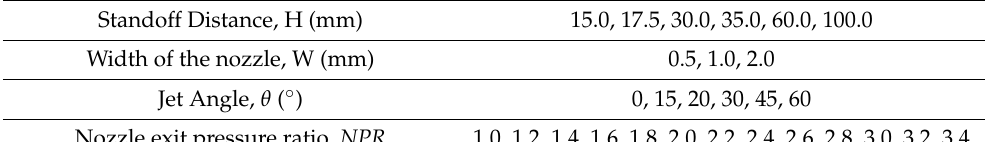
Figure 1. Schematic of oblique jet impingement on a flat plate. Table 1. Range of geometric conditions used in the